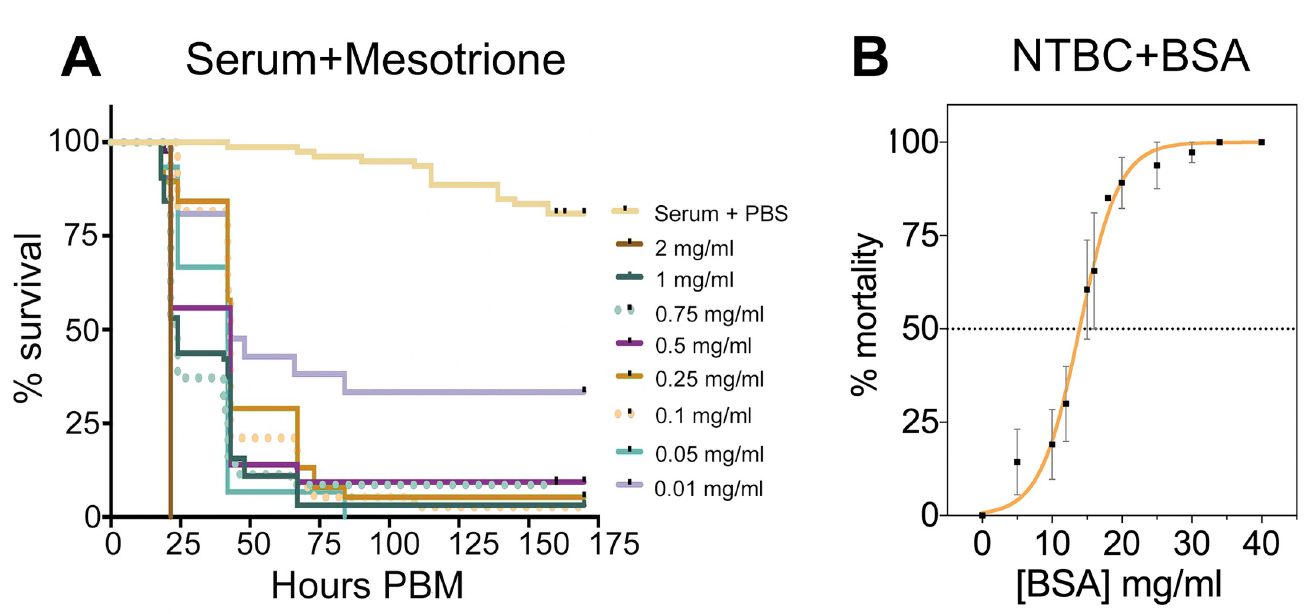
Fig 4. NTBC-associated toxicity depends on the concentration of protein in the bloodmeal. (A) Percent survival of flies fed with horse serum supplemented with PBS (control) or different mesotrione concentrations. Three independent experiments were performed: n = 10–25 tsetse per treatment (355 insects in total). (B) Tsetse mortality (percentage) was calculated after feeding flies with different concentrations of BSA as a protein source alongside a lethal concentration (0.001 mg/ ml) of NTBC. A protein concentration of 12 to 15 mg/ml is required to induce NTBC lethality (dotted horizonal line, LC 50 ). Four independent experiments were performed; each BSA concentration tested used n = 10–80 flies (788 insects in total). Data are shown as mean ± SEM. The underlying data for this figure can be found in S1 Data. BSA, bovine serum albumin; NTBC, nitisinone; PBM, post-blood meal.